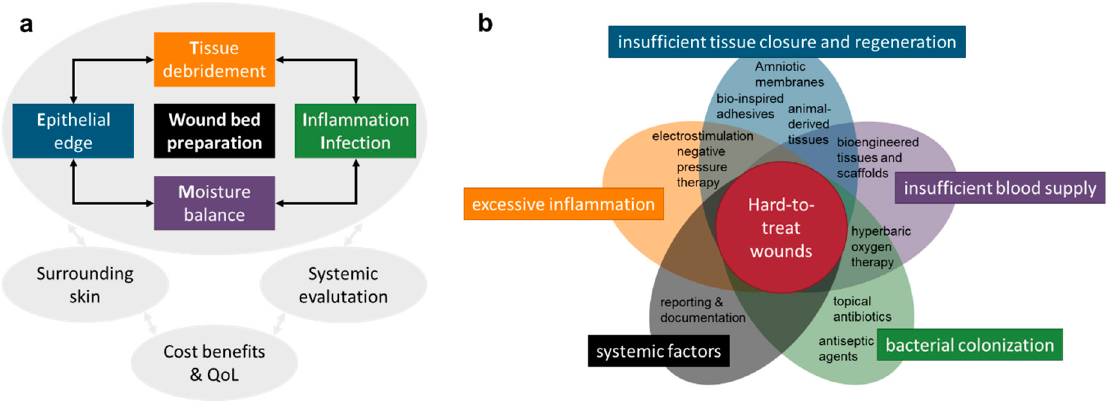
Figure 2. ( a ) Patient evaluation based on the extended TIME (tissue, infection/inflammation, moisture balance and edge of wound) principle. Adapted from [21] with permission from International Wound Journal, Blackwell Publishing Ltd. and Medicalhelplines.com Inc. ( b ) Main causes of the development of problematic wounds and currently used clinical measures to combat them. QoL: Quality of Life.